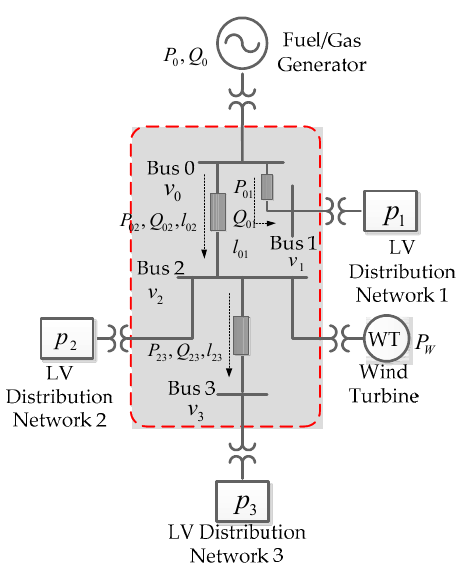
Figure 4. Microgrid single line diagram.